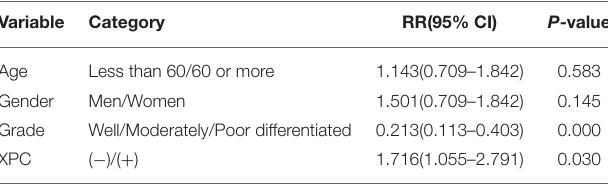
TABLE 3 | Cox multivariate regression analysis of potential survival time predictive factors in patients with colorectal